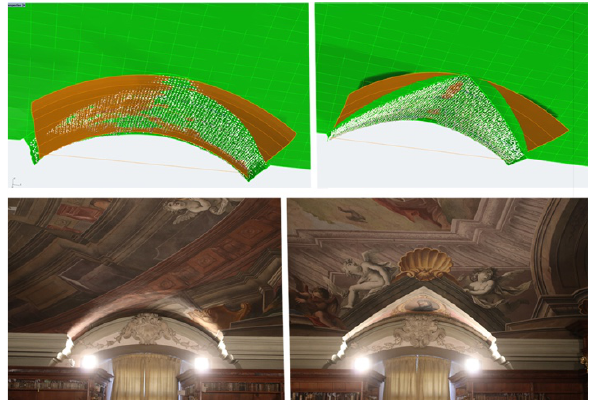
Figure 5. Comparison between the ‘smooth’ lunette of the illusionistic cupola (left) with the lunette of the other part of the vault (right). The orange represents the approximation of the shape of the ‘smooth’ lunette. The distance between the orange surface and the green one is around 5 cm